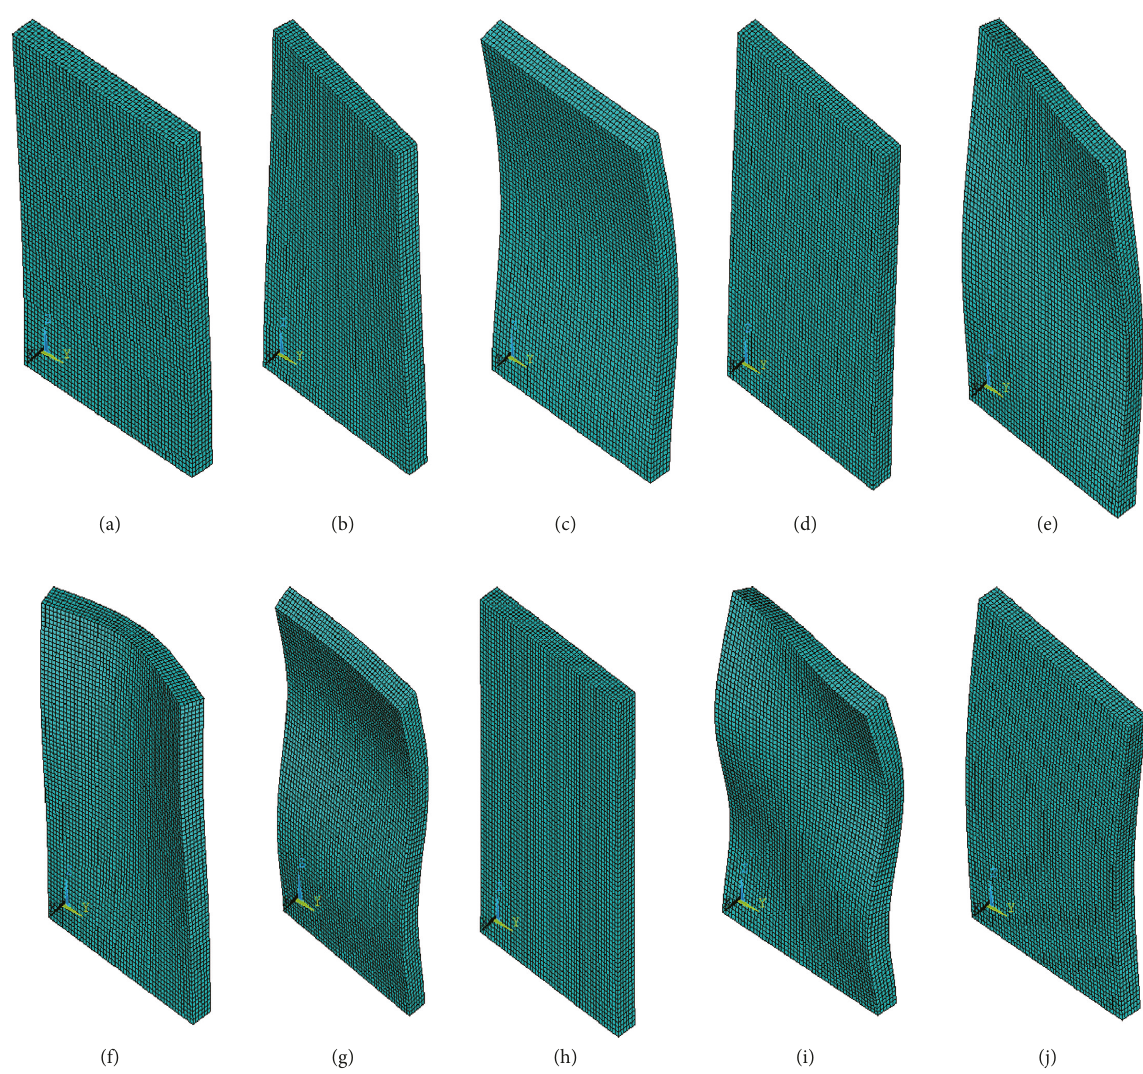
Figure 17: Modal shapes of parapet wall of the building. (a) Mode 1 ( f Mode 4 ( f 4 � 33.56Hz). (e) Mode 5 ( f 5 � 56.81 Hz). (f) Mode 6 ( f 6 � 75.94Hz). (g) Mode 7 ( f 7 � 84.15Hz). (h) Mode 8 ( f 8 � 98.38Hz). (i) Mode 9 ( f 9 � 110.20Hz). (j) Mode 10 ( f 10 �